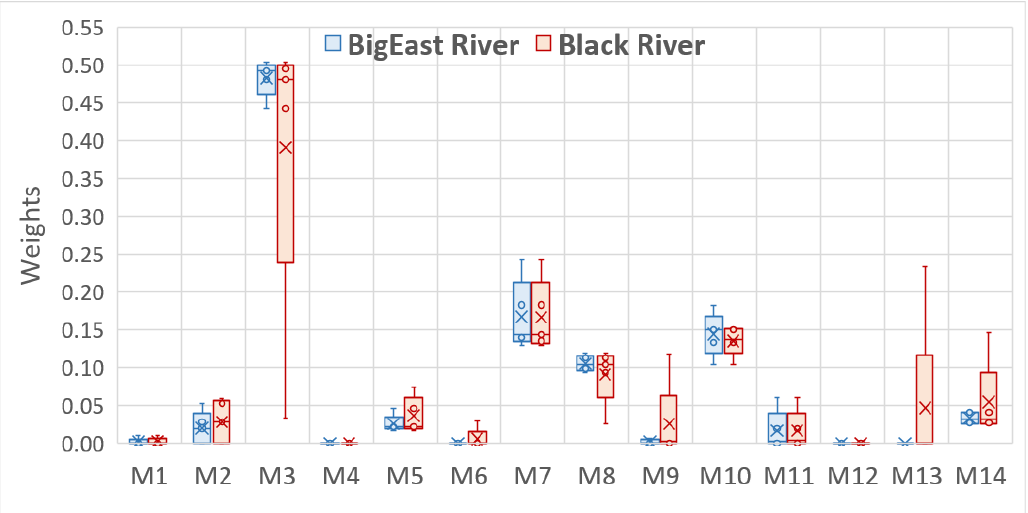
ff erent models’ weights derived from the best-selected BMA Figure 15. Scatter plots of different mode ls’ weights derived from the best -selected BMA variants. Figure 15. Scatter plots of di